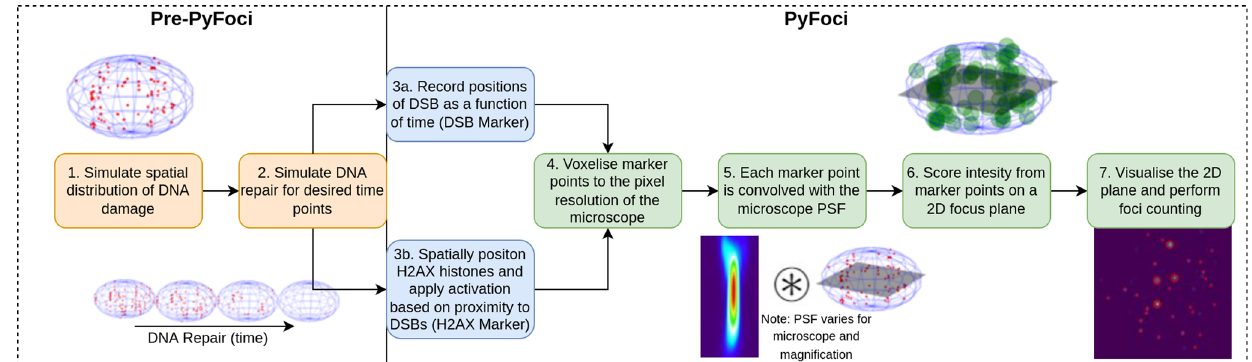
Fig. 9 Schematic overview of creating computational microscope images using PyFoci. The generation of simulated DNA DSBs and repair (steps 1 – 2) is independent of PyFoci and can be interchanged with other models. Any model which can output DSB position as a function of time can use PyFoci to create computational microscope fl uorescent foci images (for at least the Ku/DNA-PKcs marker visualisation). Steps 3a and 3b represent the choice in the visualisation approach, whilst Ku/DNA-PKcs marker only requires information on the DSB spatial distribution, the γ -H2AX marker requires information on the chromosome geometry, namely the topologically associated domains the DSBs are created in. Steps 4 – 7 are the same regardless of the visualisation marker, the only difference is what biological object is being fl uoresced (DSBs or γ -H2AX). Step 5 requires the microscopes PSF to be de fi ned for the desired microscope and magni fi cation under evaluation. Step 6 requires the user to de fi ne at what time point they wish to create the microscope image and at what z -axis slice. Step 7 creates the image and performs the foci counting on the produced image, this can be done with the in-built foci counter or can be exported to external foci counting